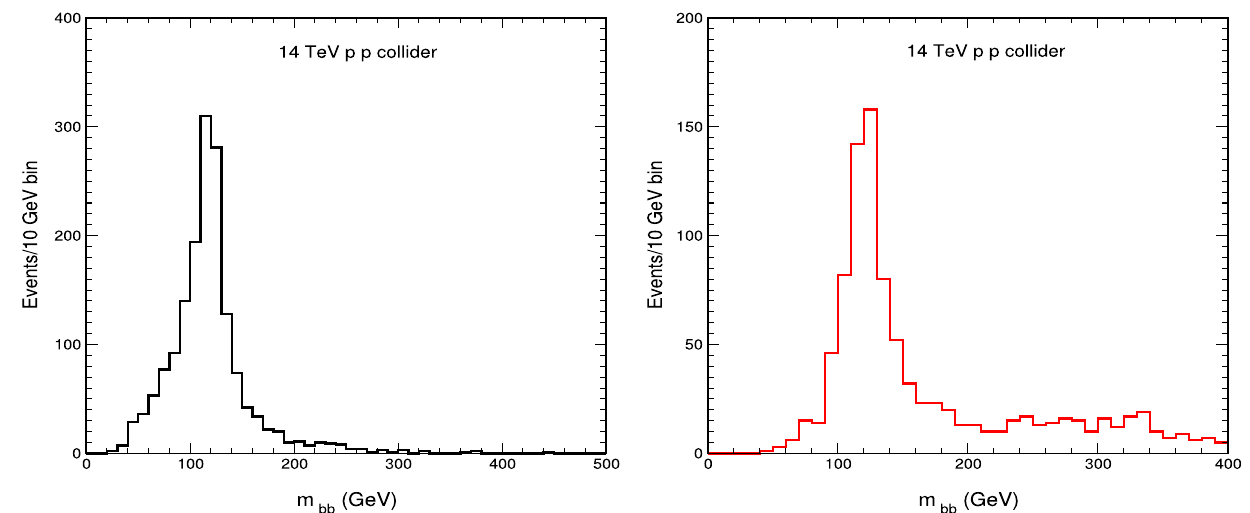
Fig. 5 The invariant mass distribution of leading (left) and subleading (right) b-jet pairs in events of pp → Z /γ → (cid:4) ++ (cid:4) −− at 14 TeV